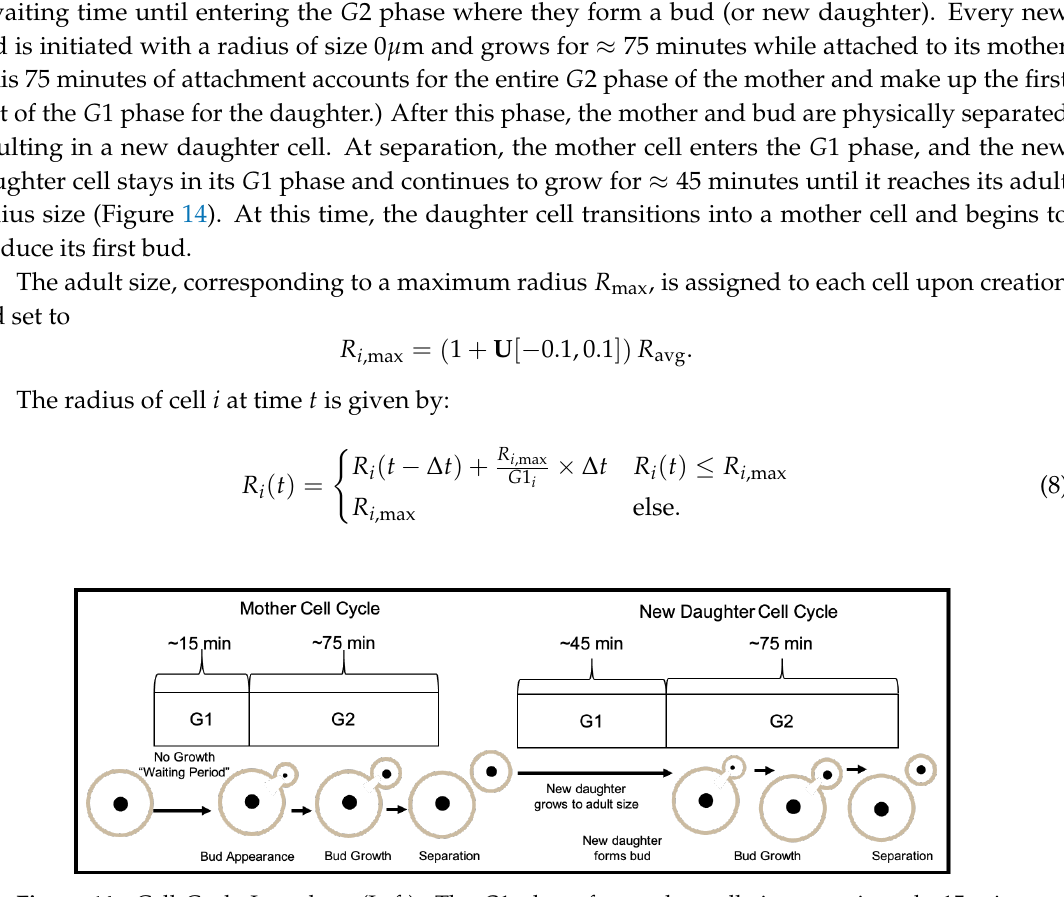
Figure 14. Cell Cycle Length. (Left): The G 1 phase for mother cells is approximately 15